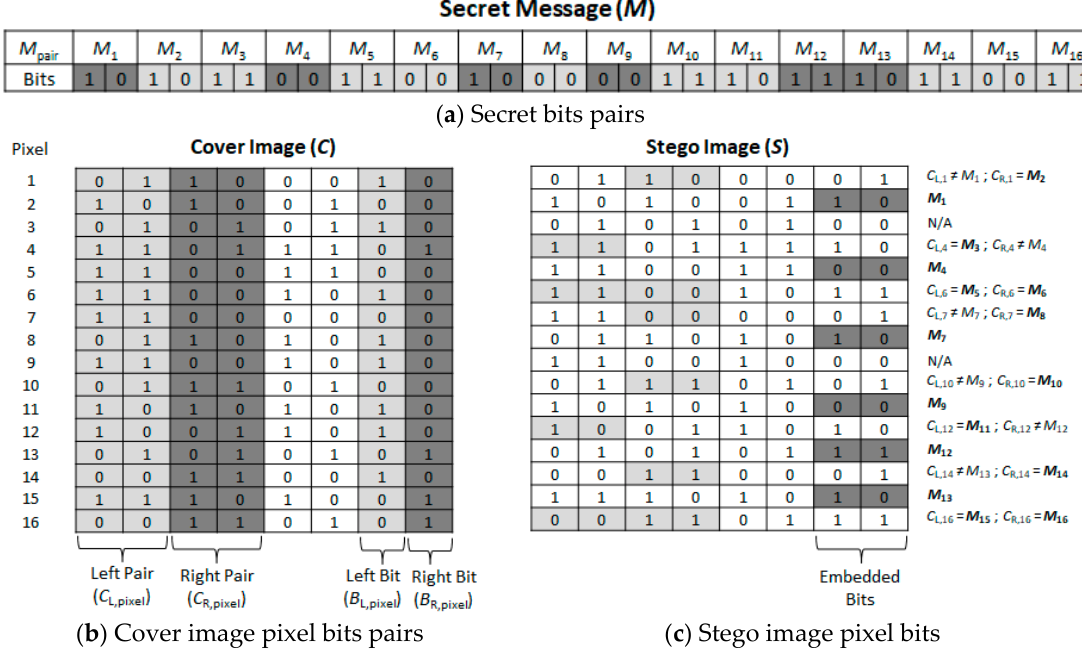
Figure 1. A secret message, cover image, and stego image pixels bits.